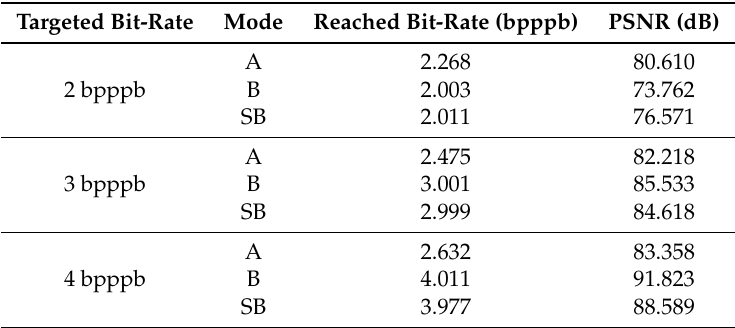
Table 3. Bit-rate accuracy depending on the selected control mode.